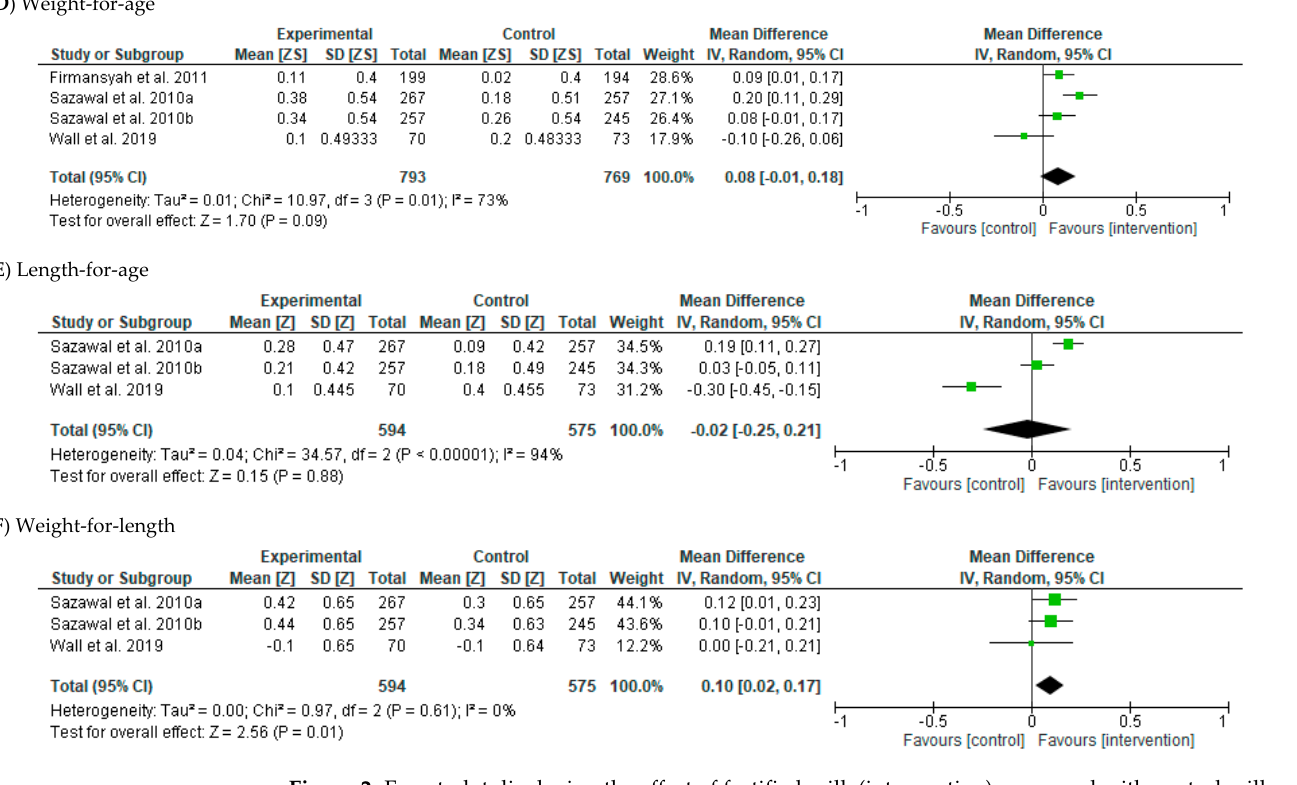
Figure 2. Forest plot displaying the effect of fortified milk (intervention) compared with control milk on the mean difference in ( A ) weight gain (kg); ( B ) length (cm); ( C ) body mass index (kg·m 2 ); ( D ) weight-for-age (z-score); ( E ) length-for-age (z-score); ( F ) weight-for-length (z-score). Note: The study-specific mean differences and 95% confidence intervals are represented by the green squares and horizontal lines, respectively. The size of the square represents the weight given to each study in the meta-analysis. The shaded diamond represents the pooled mean difference, and the width of the diamond represents the pooled 95% confidence interval.